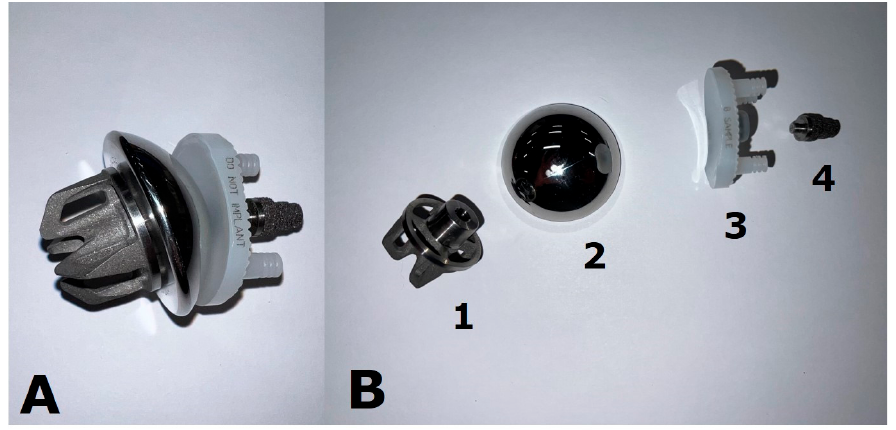
Figure 1. Example of a stemless shoulder implant. This prosthesis is shown ( A ) assembled and ( B ) deconstructed. The humeral head is secured to the cut humeral surface via an “anchor”, which is fluted and ridged to facilitate osseous integration. The anchor (1) and humeral head (2) are joined via a Morse taper. This implant allows for the preservation of humeral bone stock and functions as a resurfacing-type construct. The glenoid component (3) is composed of polyethylene plastic. The top and bottom pegs are cemented in place, while the metal post (4) is press-fit and allows for biologic osseous integration.